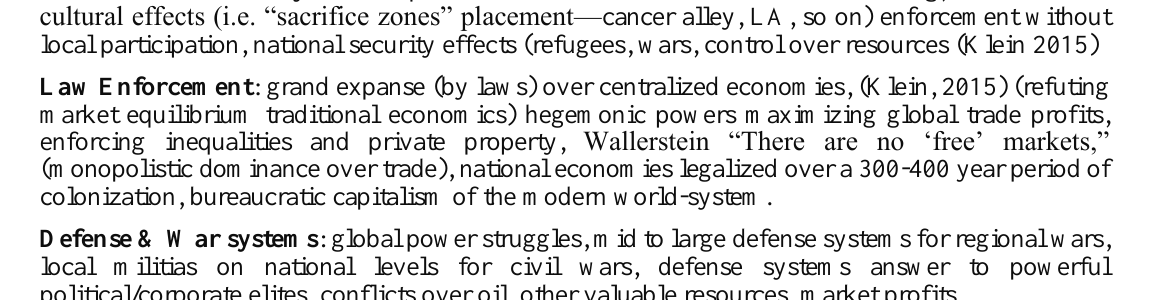
Table 3. Narrative describing problems of current social (sphere) constructs. Political : centralized system of (political) control over societal decision-making, economic and cultural effects (i.e. “sacrifice zones” placement—cancer alley, LA, so on) enforcement without local participation, national security effects (refugees, wars, control over resources (Klein 2015) Law Enforcement : grand expanse (by laws) over centralized economies, (Klein, 2015) (refuting market equilibrium traditional economics) hegemonic powers maximizing global trade profits, enforcing inequalities and private property, Wallerstein “There are no ‘free’ markets,” (monopolistic dominance over trade), national economies legalized over a 300-400 year period of colonization, bureaucratic capitalism of the modern world-system. Defense & War systems : global power struggles, mid to large defense systems for regional